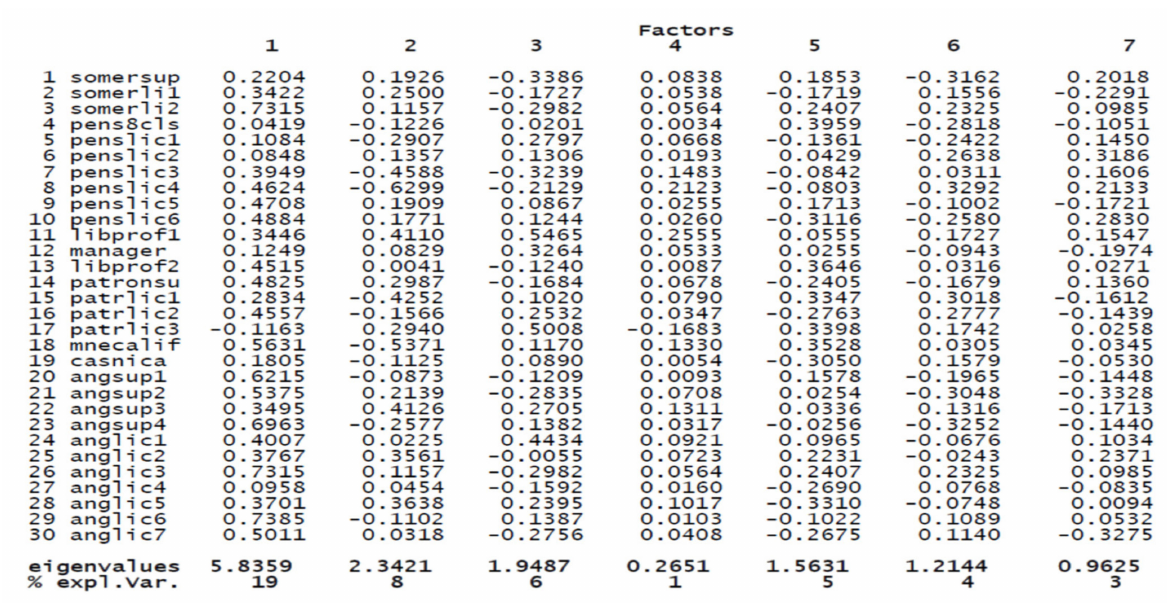
Figure 3. Unrotated factors matrix.